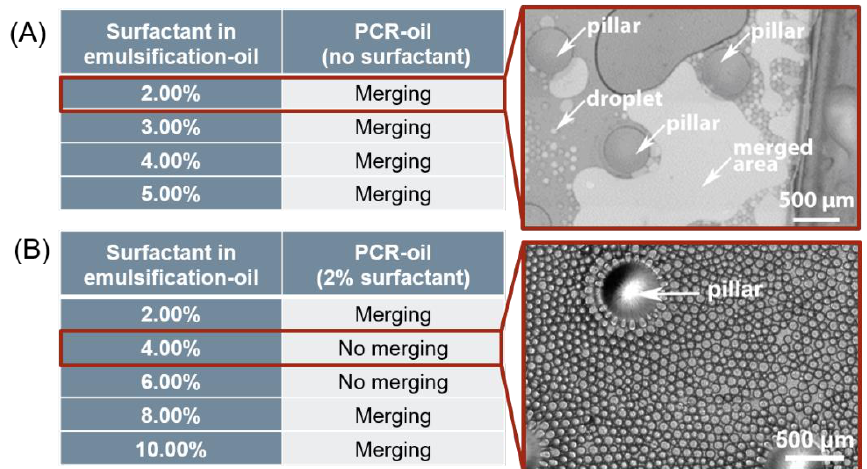
Figure 4. Evaluation of surfactant concentration in emulsification-oil and PCR-oil. ( A ) A mix of 2–5% surfactant in emulsification-oil combined with pure PCR-oil. The microscopy image shows merged areas as bright. ( B ) A mix of 2–10% surfactant in emulsification-oil combined with 2% surfactant in PCR-oil. Exemplary microscopy image shows a droplet area with 4% surfactant in emulsification-oil.